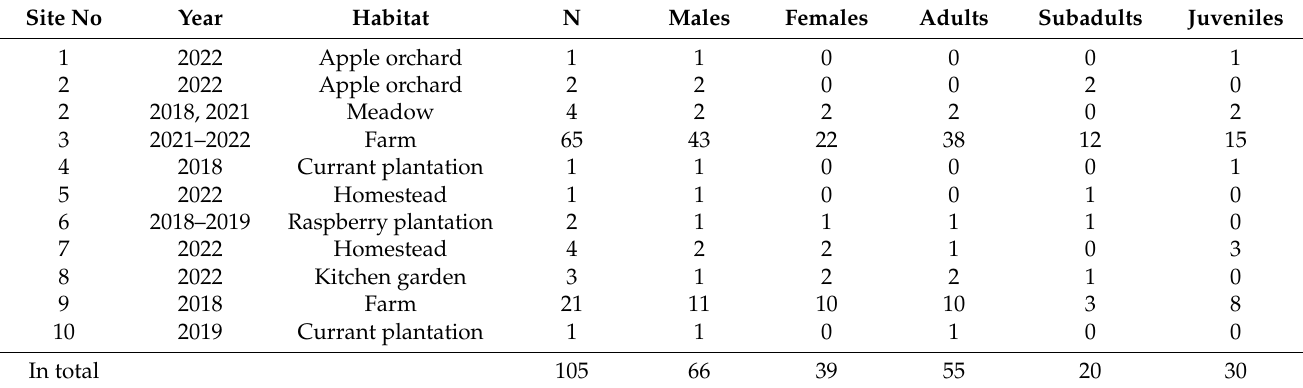
Table 1. M. musculus sample size for stable isotope